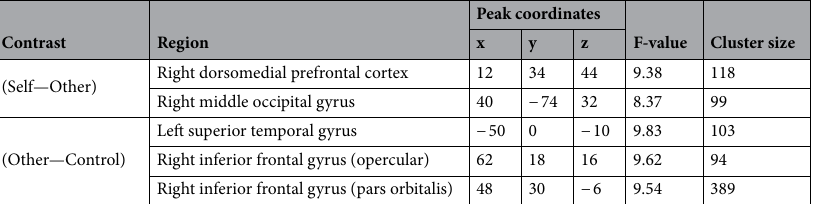
Table 3. Peak coordinates of areas with between-group differences in activation levels. This table shows the results of the whole-brain activation analysis for the different contrasts, with the corresponding peak region names, their MNI coordinates, peak F value, and cluster size.